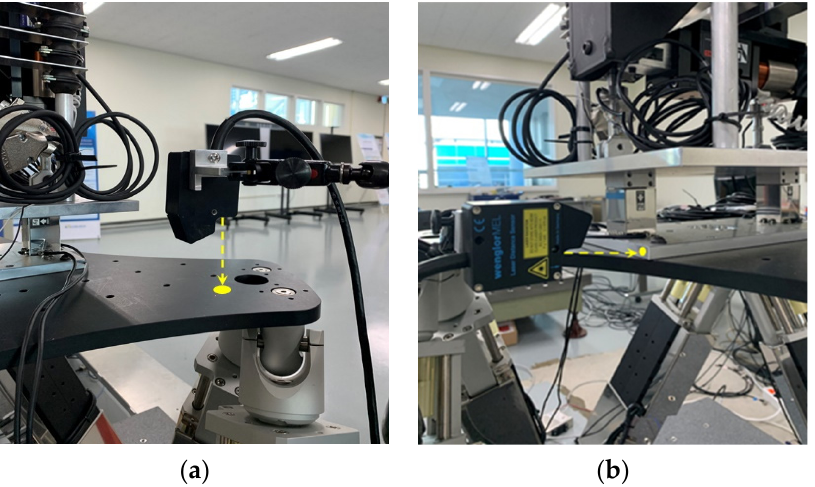
Figure 5. Stewart platform displacement measurement obtained using laser displacement-measuring sensor: ( a ) vertical displacement, ( b ) lateral displacement.